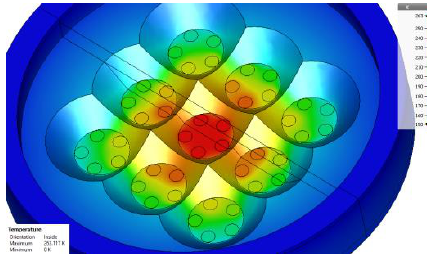
Fig. 3. Temperature distribution in polepiece for the design on Fig. 2.